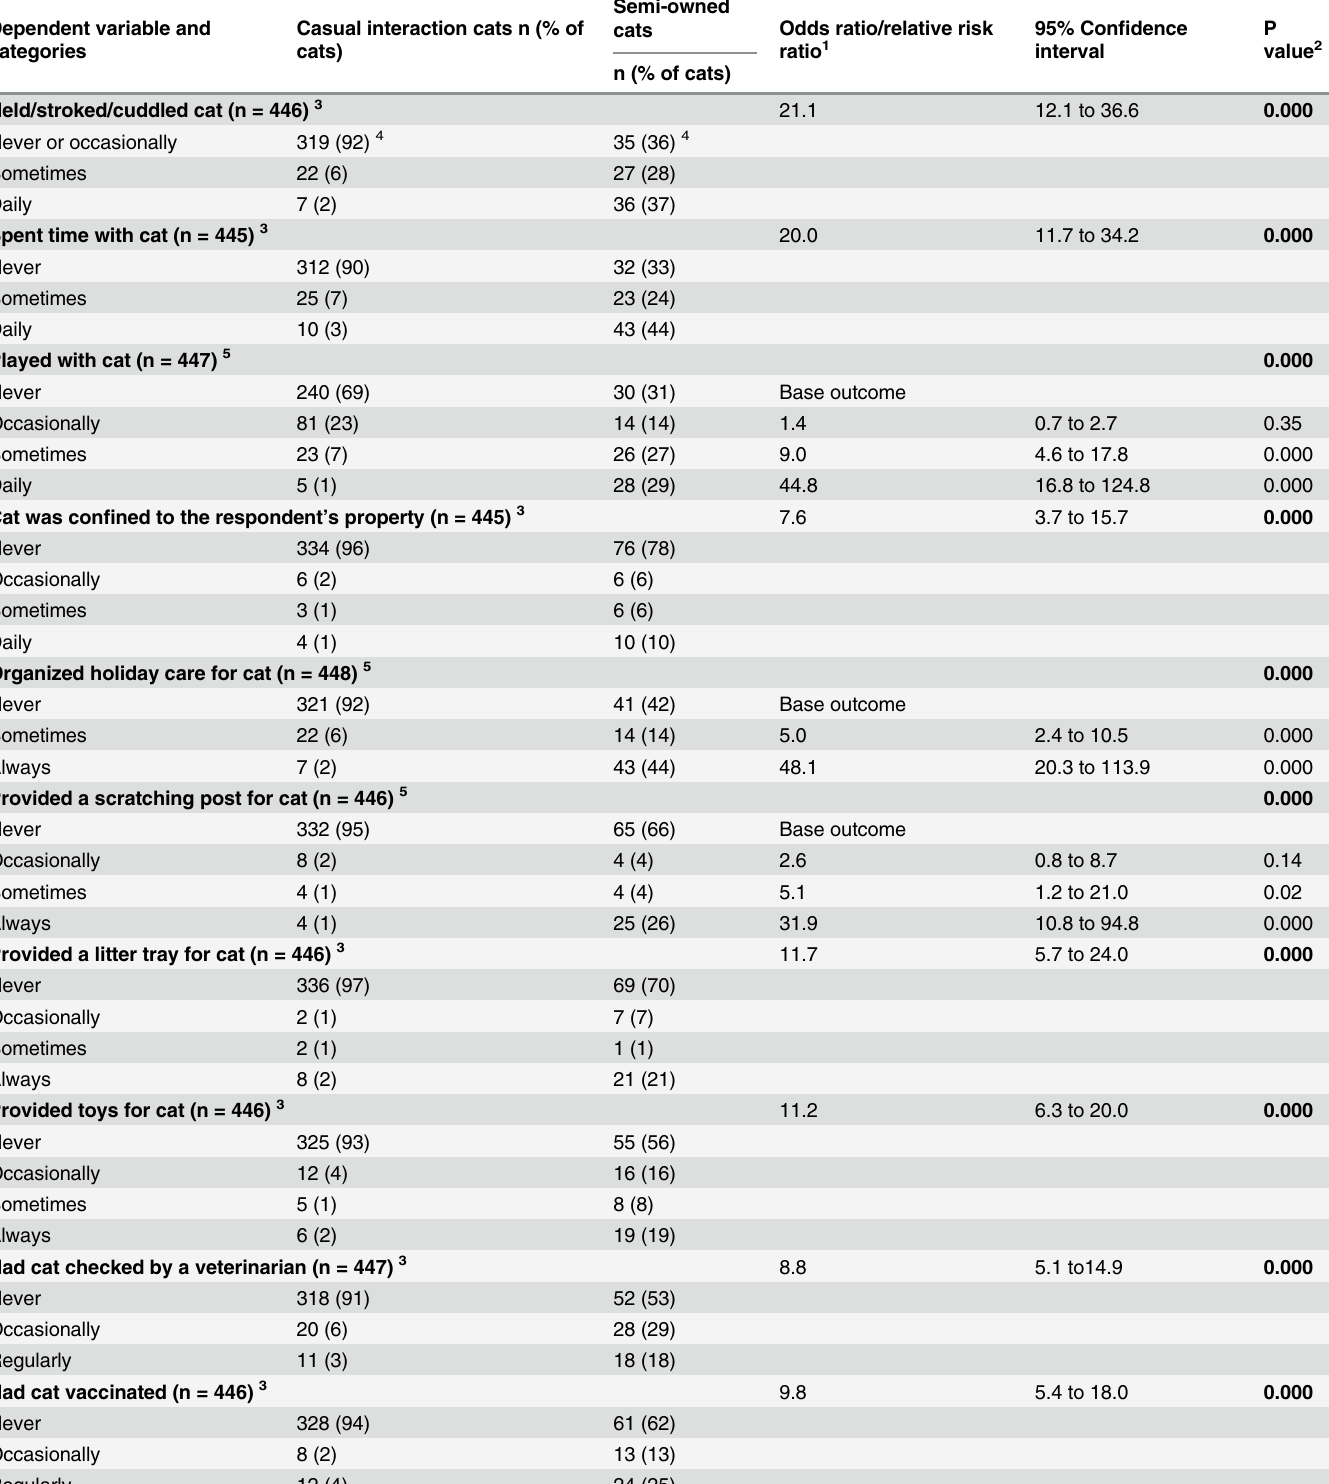
Table 3. Distributions of study cats in semi-ownership and casual interaction human-cat relationships that had received various interactions and caretaking behaviours and associations between these and the human-cat relationship of the study